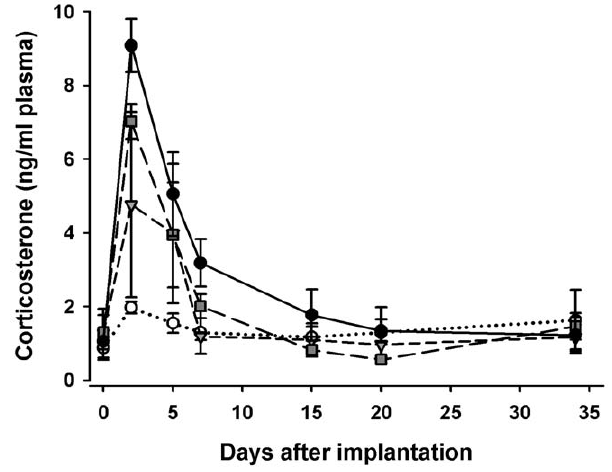
Figure 1. Corticosterone concentrations in plasma after pellet implantation. Mean ( 6 SE) concentrations of corticosterone in plasma of each three hens implanted with 90-day corticosterone release pellets N in four different pellet dosages (7.5 mg # , 15 mg . , 20 mg & and 30 mg